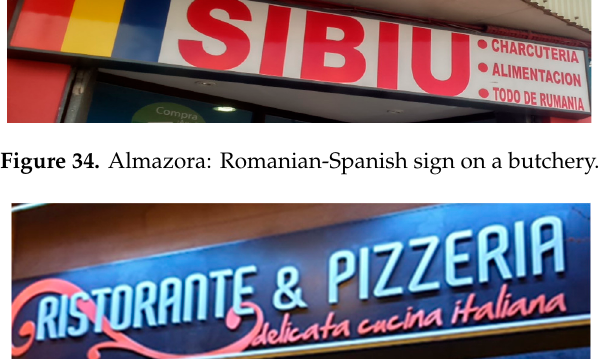
Figure 35. Almazora: Italian sign on a restaurant .